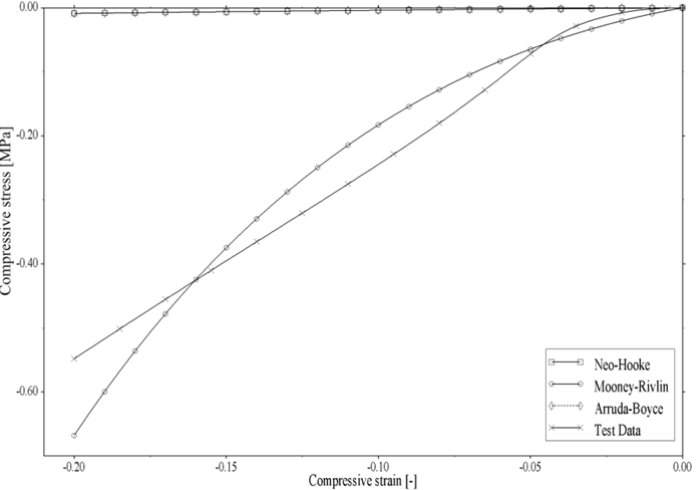
Fig. 8 Experimental data and material laws for Sikasil ® SG-500 under